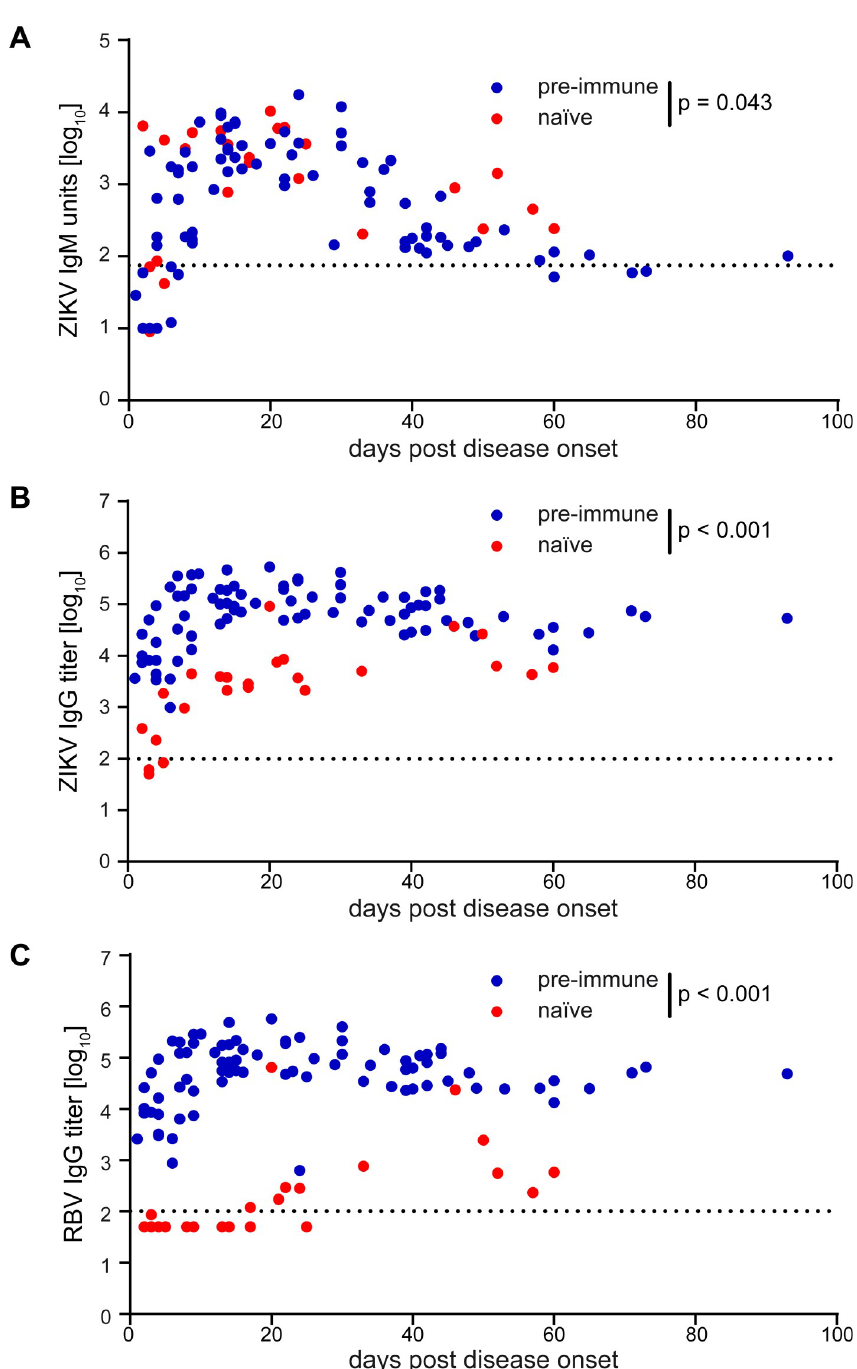
Fig 10. Quantification of Zika virus-specific IgM and IgG antibodies and broadly cross-reactive IgG antibodies using single serum samples from Zika cases. (A) Zika virus IgM ELISA units, (B) Zika virus IgG ELISA titers, and (C) Rio Bravo virus IgG ELISA titers of individual samples are plotted against days after disease onset. Data points represent means from two to three (A) or three (B, C) independent experiments. Flavivirus pre-immune patients are color-coded in blue, flavivirus na ï ve patients in red. Dotted lines indicate the cut-off of each assay. The significance of differences between the extents of na ï ve and pre-immune antibody responses were calculated based on the maxima reached, applying a general linear model as described in Methods. p-values are indicated in the graphs. ZIKV, Zika virus; RBV, Rio Bravo virus.